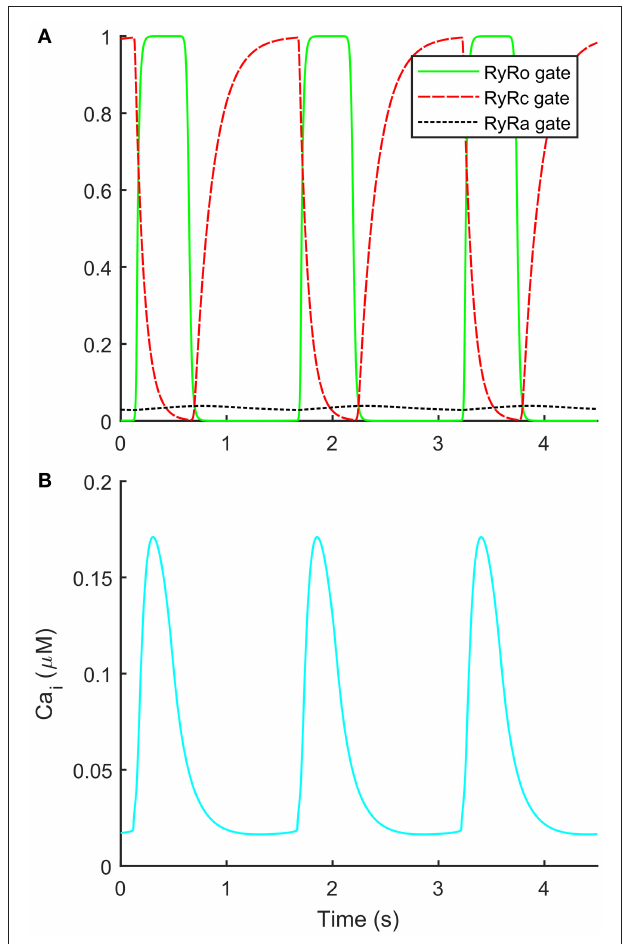
FIGURE 4 | Details on the new formulation of the Ca 2 + release from sarcoplasmic reticulum. (A) Time-course of the three sarcoplasmic release current gates during spontaneous action potentials. (B) Ca 2 + transients during spontaneous action potentials.